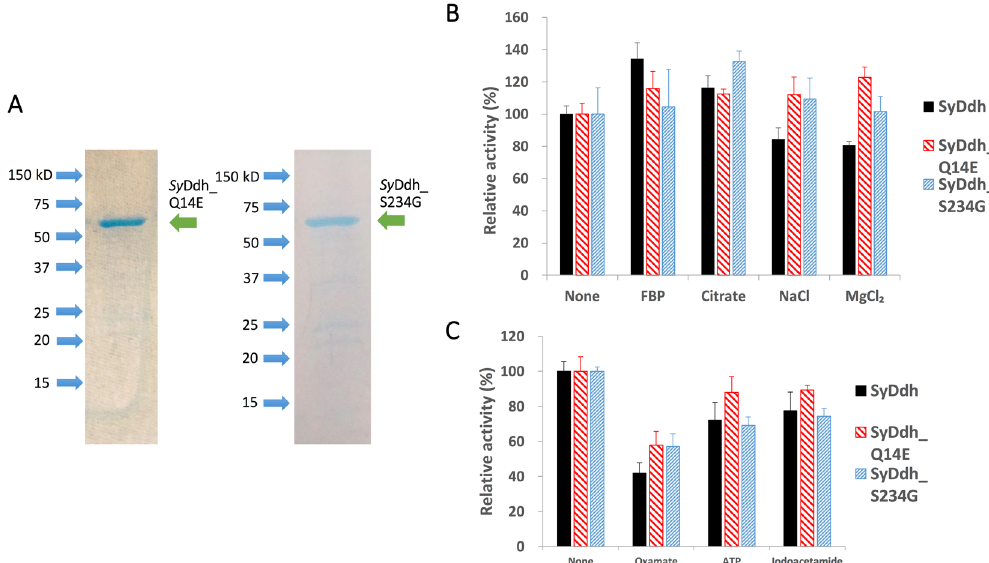
Figure 5. Enzymatic assay of Sy Ddh with a single substituted amino acid residue. Sy Ddh_Q14E and Sy Ddh_ S234G are Sy Ddh with the glutamine at position 14 substituted with glutamate and with the serine at position 234 substituted with glycine, respectively. ( A ) Purification of GST-tagged Sy Ddh_Q14E and Sy Ddh_S234G after separation by electrophoresis on a 12% SDS-PAGE gel. The gel was stained with InstantBlue reagent. Arrowheads indicate the molecular weight. ( B and C ) Enzymatic activity in the presence of effectors. Each effector was added at a concentration of 2.5 mM. Ddh activity was measured at 30°C and pH 7.5 using 60 pmol Sy Ddhs. The graphs show the mean ± SD obtained from four independent experiments. Each activity of Sy Ddhs in the absence of effectors was set at